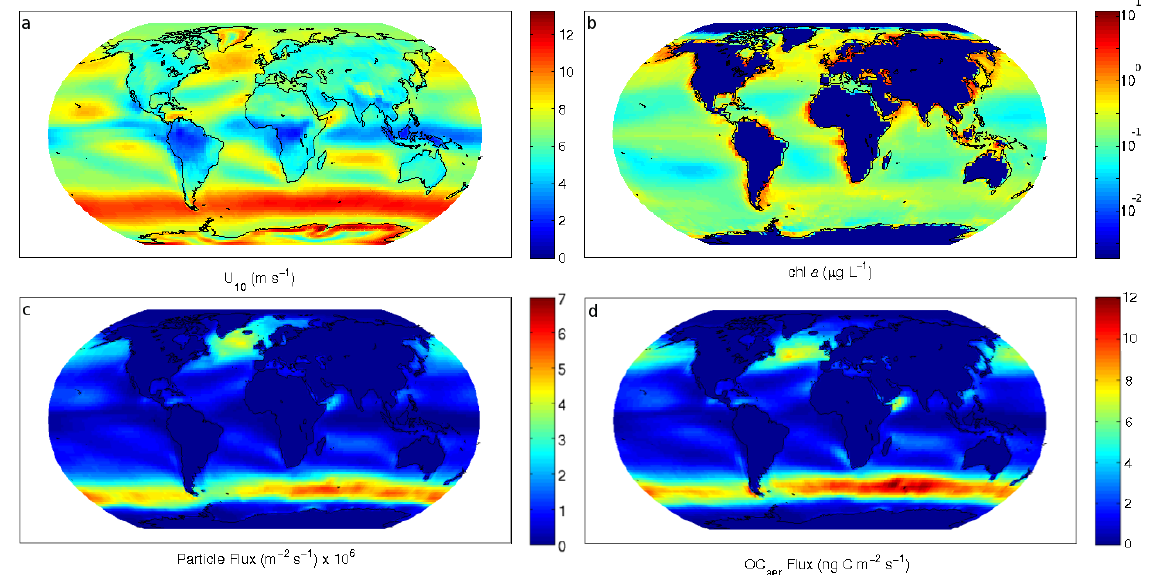
Fig. 4. Simulated spatial distributions of (a) U 10 , (b) surface ocean chl- a , (c) total number production flux of nascent marine aerosol, and (d) the corresponding OC aer flux averaged over